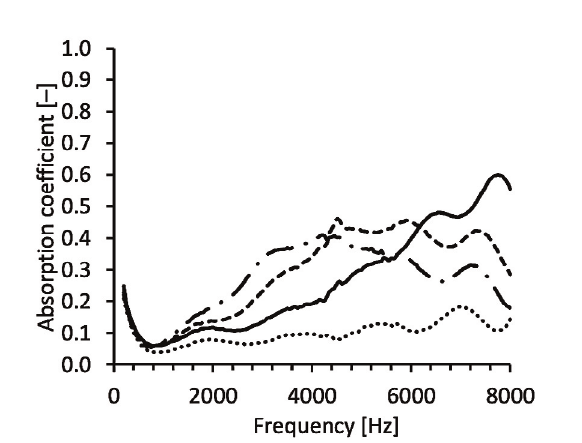
Fig. 10. Absorption coefficient for one microperforated plate (material A), distance X1 was set from 0 mm (dotted line) to 15 mm (dash-dotted